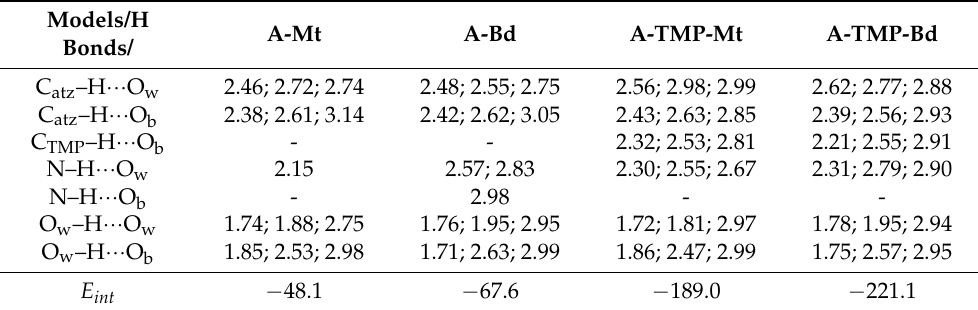
Table 2. The hydrogen bond distances, H ··· A, (min; median; max) (Å), intercalation energy, ∆ Eint